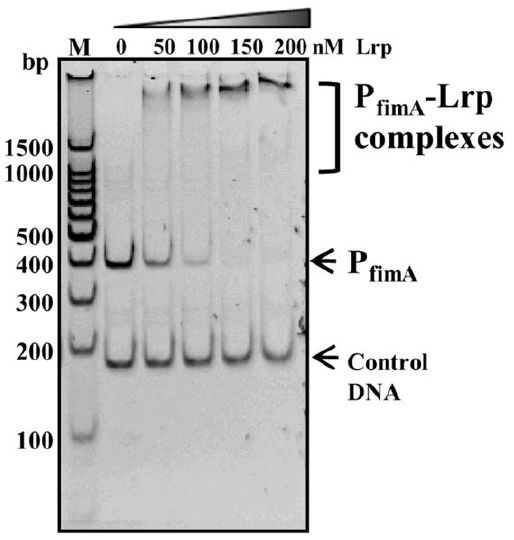
Figure 2. Binding of the purified Lrp to the wild-type P fimA . Binding reactions were carried out in various Lrp concentrations: 0, 50, 100, 150, and 200 nM. The 178-bp DNA fragment from pBluescript multi-cloning sites was used as the negative control.